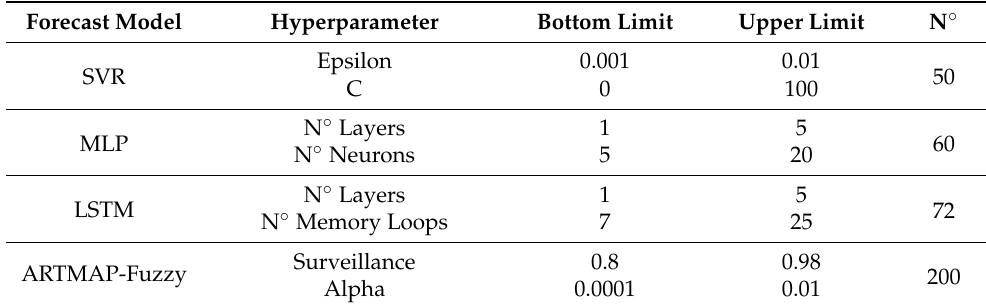
Table 4. Hyperparameter range used in optimization.